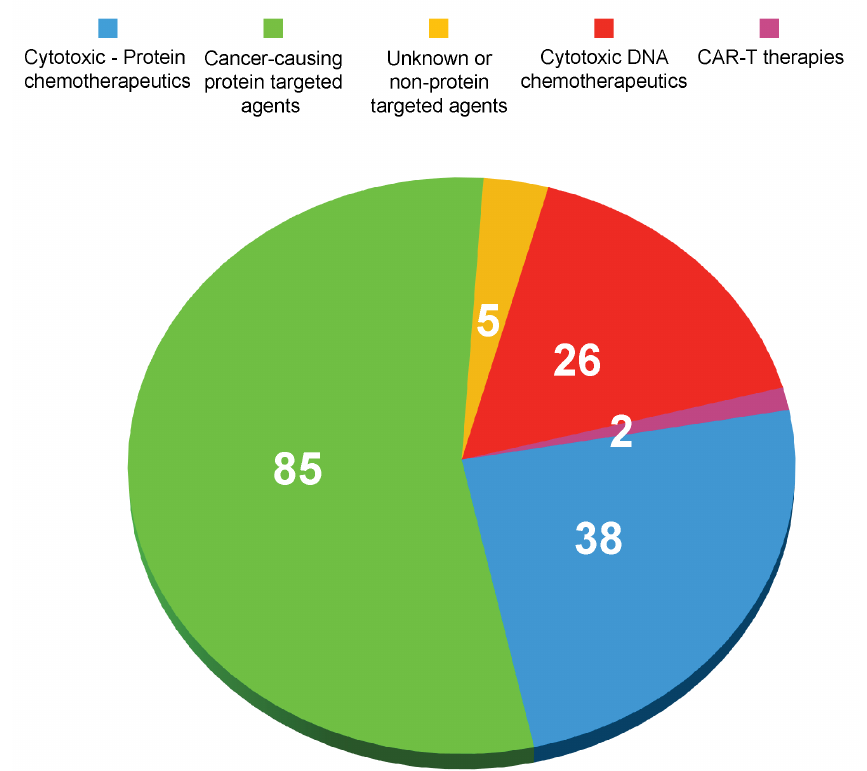
Figure 1. Mechanistic distribution of current US Food and Drug Administration-approved anticancer drugs. The classification scheme in this figure was inspired by Santos et al. 3 . CAR–T, chimeric antigen receptor–T